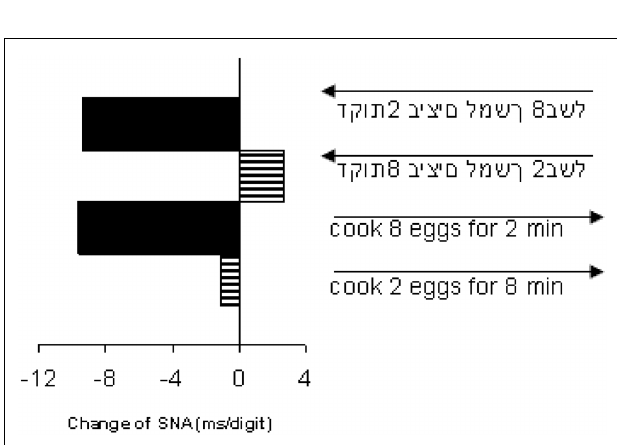
FIGURE 2 | Change in SNAs of Hebrew and English participants reading cooking recipes with different number magnitudes at the beginning and end of each line. Change was measured per regression slopes calculated from number classification speed in the parity task before vs. after reading. In both languages only the incongruent SNA (large number at sentence start) induced a change. Arrows above text excerpts indicate reading direction. Adapted from Fischer et al.